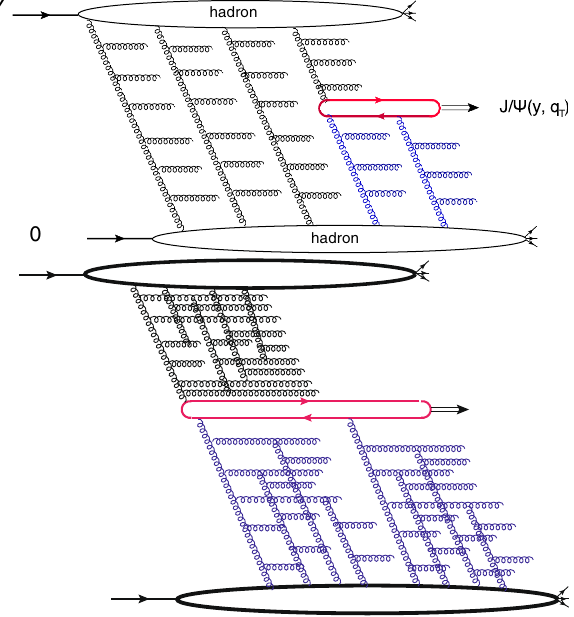
Fig. 3 Upper plot: contribution of the multigluon ladders to the enhanced multiplicity of charged particles N ch which leads to a lin- ear dependence on n . Lower plot: multiplicity enhancement from BK cascade, subject of study in this paper Q s ( y , b ) → Q s ( y , b , n )